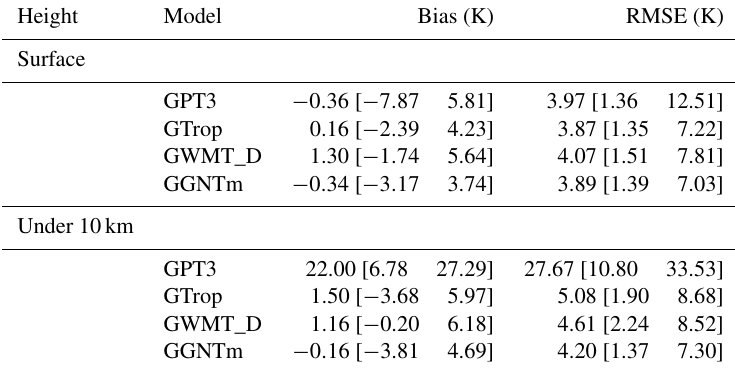
Table 2. Mean bias and mean RMSE of T m values at 428 globally distributed radiosonde stations in 2018 resulting from GPT3, GTrop, GWMT_D, and GGNTm.